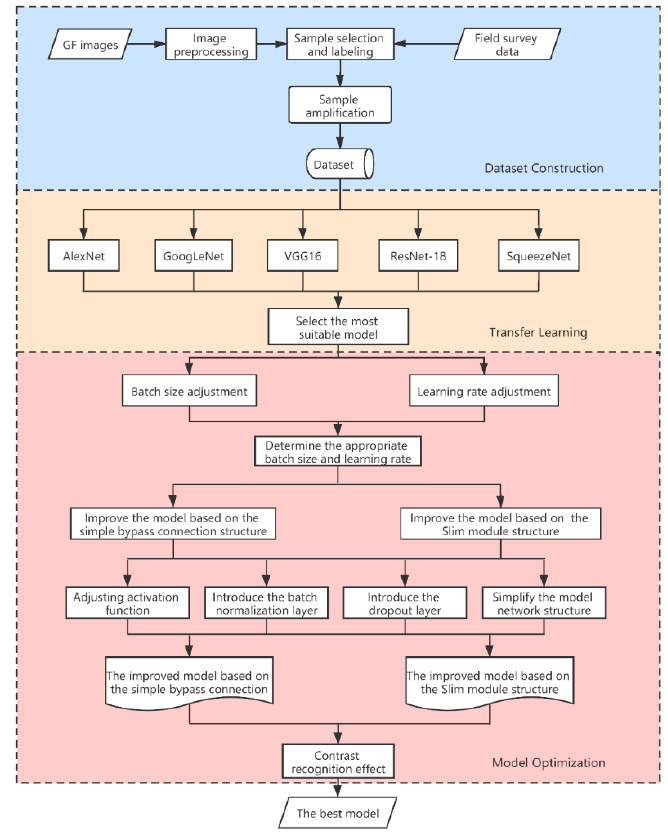
Figure 2. Flow diagram of experiment.